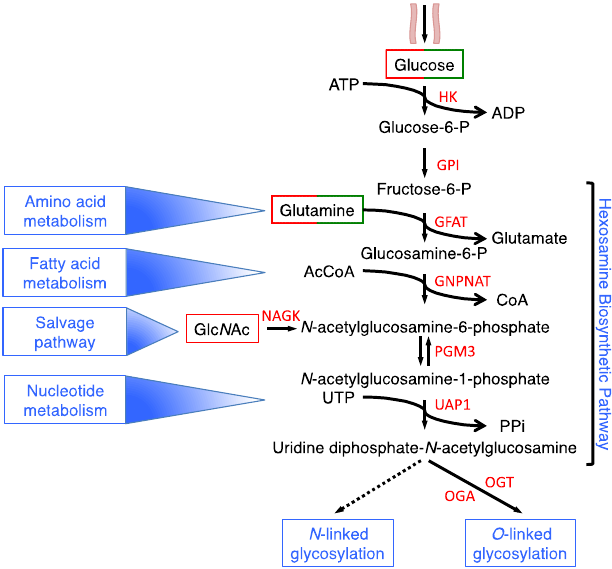
Figure 1. Schematic representation of the hexosamine biosynthesis pathway. HBP enzymes are depicted in red, metabolites in black, cellular processes in light blue. The green/red boxes indicate the metabolites whose change induces UDP-Glc N Ac decrease (green) or increase (red). In fact, hexokinase (HK) phosphorylates glucose to produce glucose-6-phosphate, which is then converted into fructose-6-phospate by phosphoglucose isomerase (GPI). Fructose-6-phospate and glutamine are converted into glucosamine-6-phosphate (GlcN-6P) and glutamate (Glu) by the first HBP rate-limiting enzyme glutamine: fructose-6-phosphate transaminase (GFAT). The next enzyme, glucosamine-phosphate N -acetyltransferase (GNPNAT) converts the GlcN-6P and the Acetyl-Coenzyme A (Ac-CoA) into N -acetylglucosamine-6-phosphate (Glc N Ac-6P) and CoA. Then,